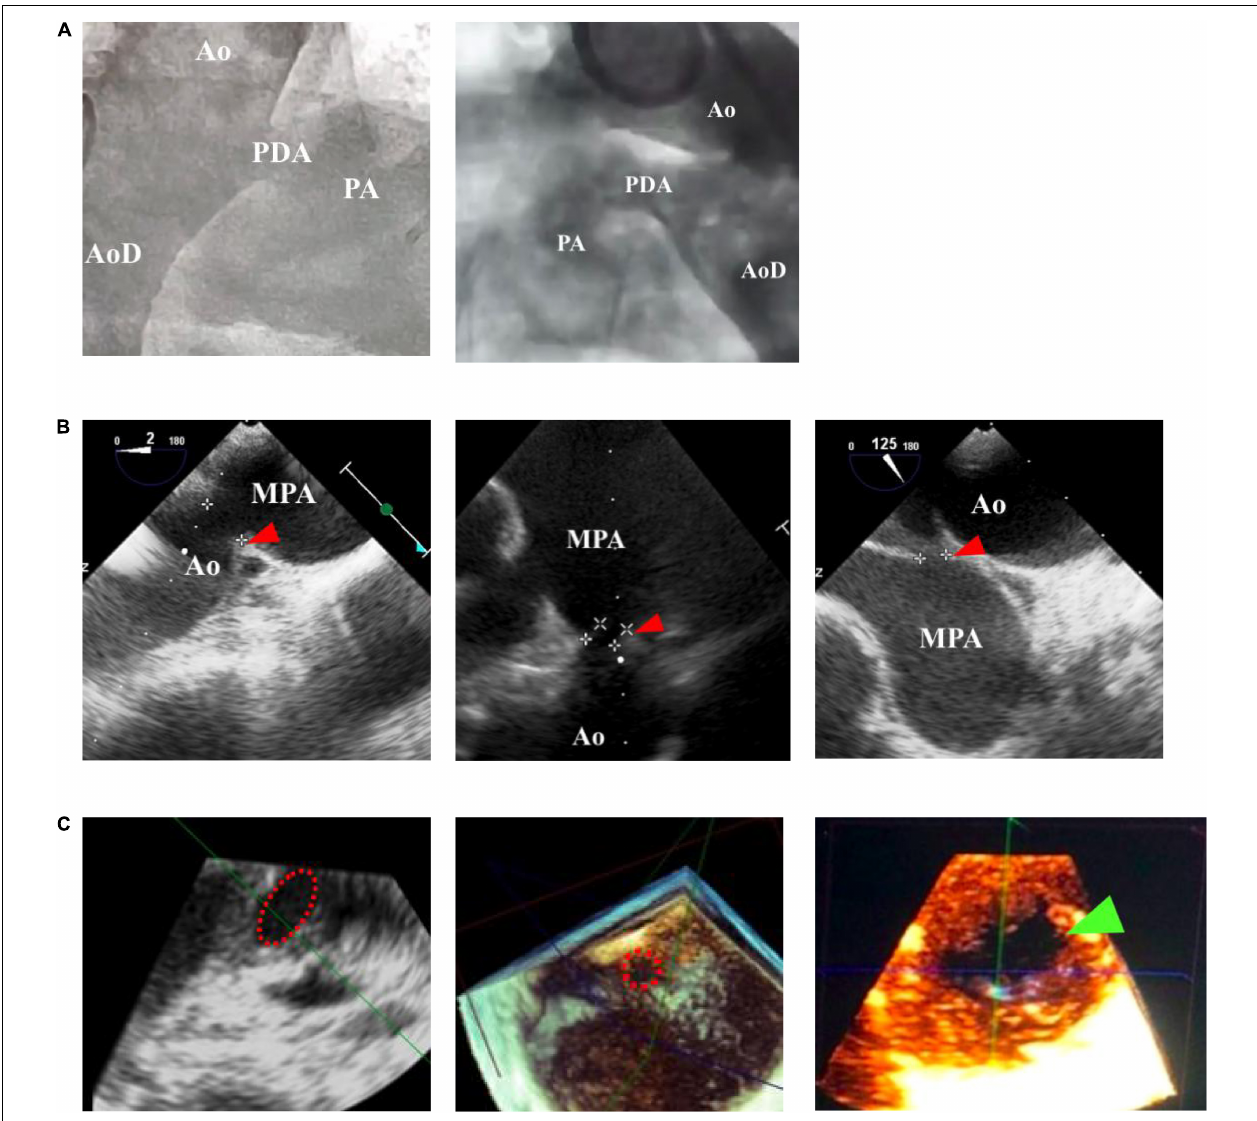
FIGURE 1 | Comparison of patent ductus arteriosus (PDA) size and morphology measurements using fluoroscopy and echocardiography guidance. (A) Fluoroscopy can only provide a 2-dimensional image, whereas (B) transthoracic echocardiography (TTE) and transesophageal echocardiography (TEE) can provide a 3-dimensional structure as shown by the red arrowhead. (C) Cross-sectional PDA morphology measured by using transesophageal echocardiography (TEE), indicated by the dotted red circle. Green arrowhead showed oval-shaped PDA. Ao, aorta; AoD, descending aorta; MPA, main pulmonary artery; PA, pulmonary